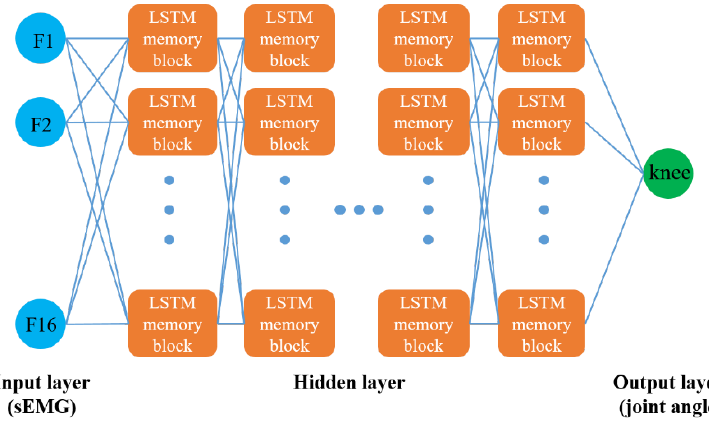
Figure 6. Topological structure of the LSTM network.